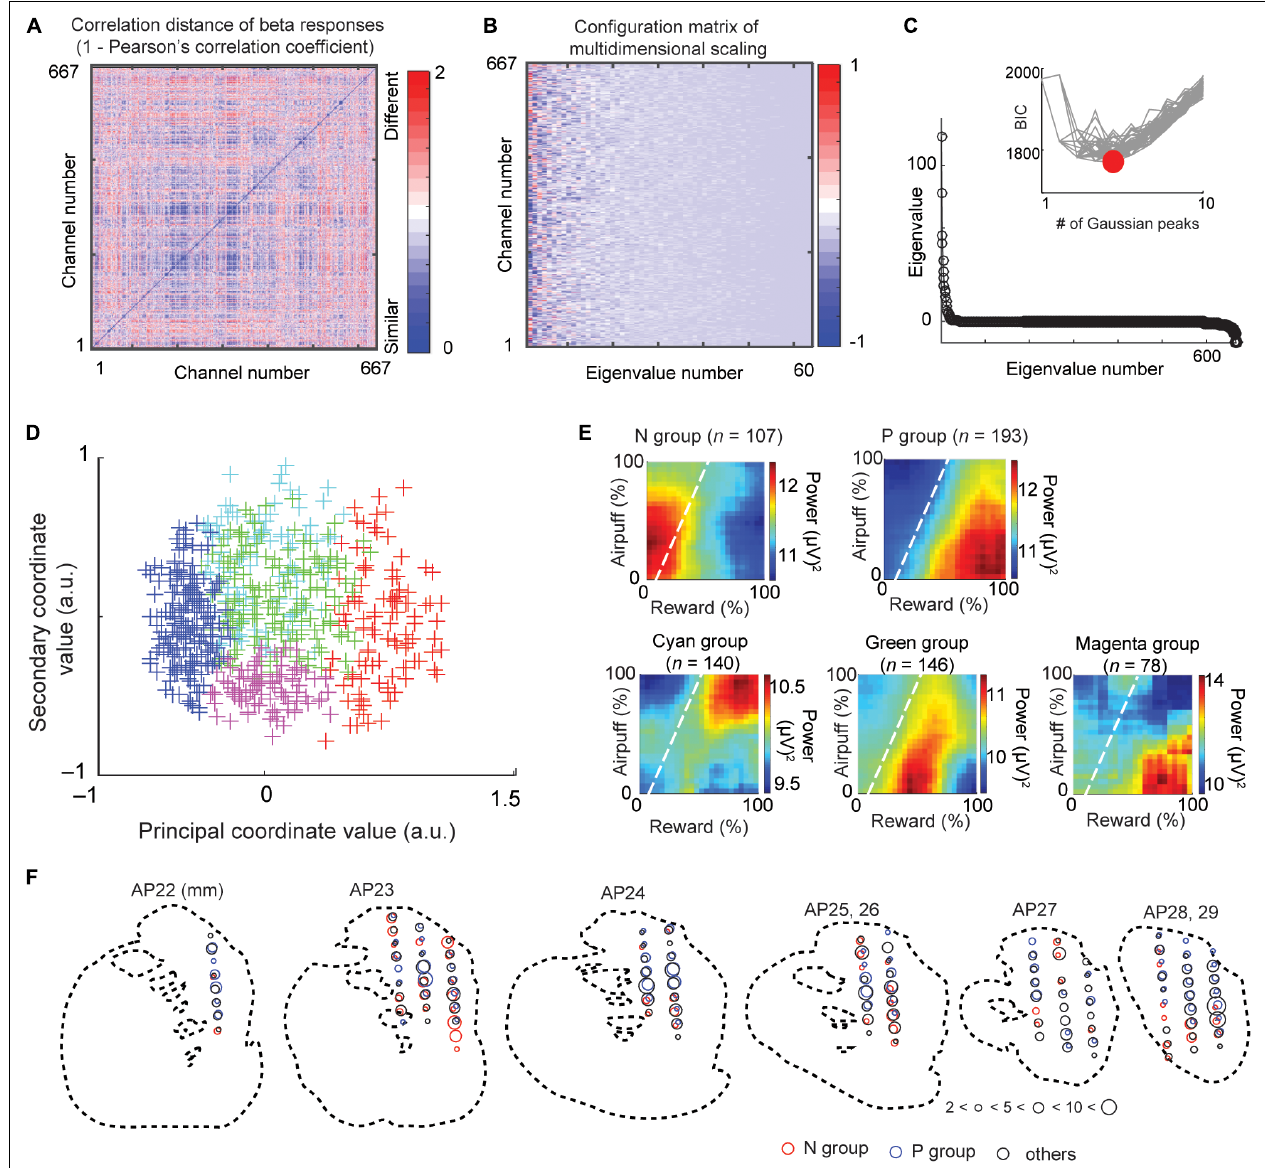
FIGURE 3 | Multidimensional scaling and clustering of beta responses. (A) Matrix of correlation distance between pairs of all beta response matrices ( D = [ d ij ]). The color of each element shows the correlation distance ( d ij = 1 - r ij ), where r ij is the cross-correlation between decision matrices of beta response i and response j . (B) Configuration matrix derived from the multidimensional scaling. (C) Eigenvalues showing the explanatory power of each feature dimension. Inset shows the BIC values for different numbers of Gaussian peaks. Gray lines indicate the BIC values for each of many independent runs of a procedure that did the mixture-of-Gaussian fitting for each number of peaks from 1 to 10. The minimum BIC was given by five Gaussian peaks and denoted as a red circle. (D) Beta response matrices projected onto the first two dimensions of the MDS. Each cross indicates an individual channel. The color indicates the group that the channel belongs to (red: N group, blue: P group, green, cyan, and magenta: other groups). (E) The group means of beta responses in the decision matrix. Each group (N, P, cyan, green, or magenta group) was defined by the MDS clustering shown in (D) . (F) Spatial distribution of sites at which we recorded LFPs classified as N (red), P (blue), and other (black) groups. The size of each circle indicates the number of LFPs at the location. Data from monkey S were projected onto outline drawings of the striatum of monkey P.